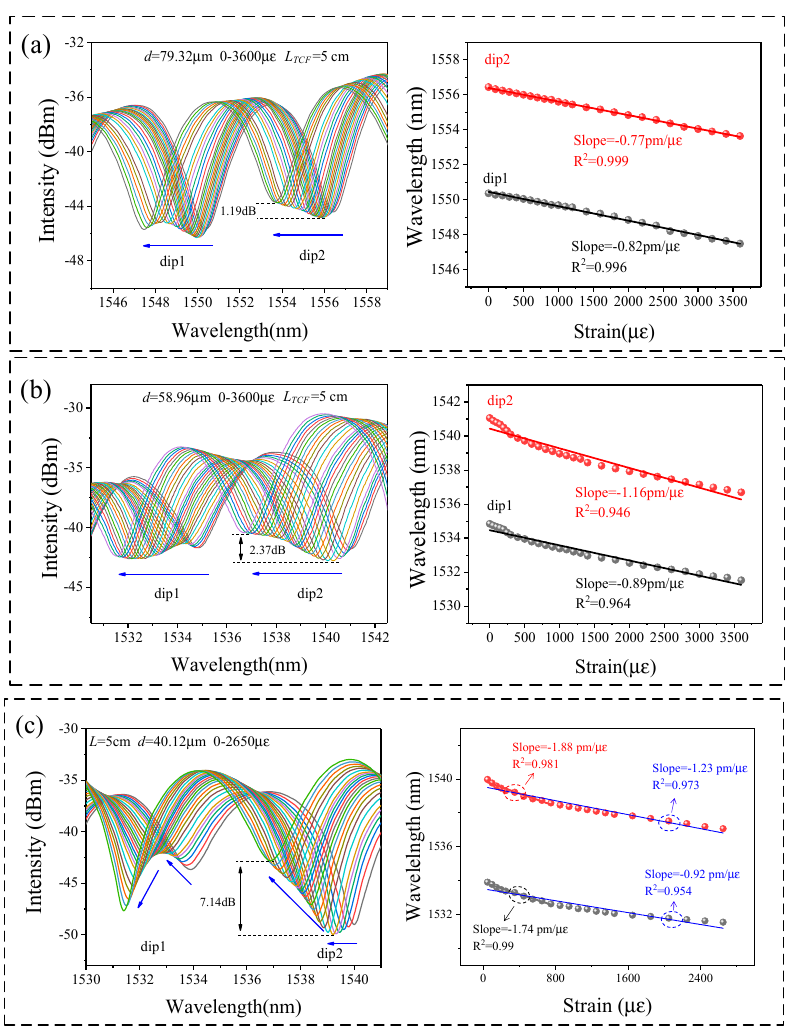
Figure 7. Transmission spectra and the axial-strain responses when ( a ) d = 79.32 µm ( b ) d = 58.96 µm, and ( c ) d = 40.12 µm.